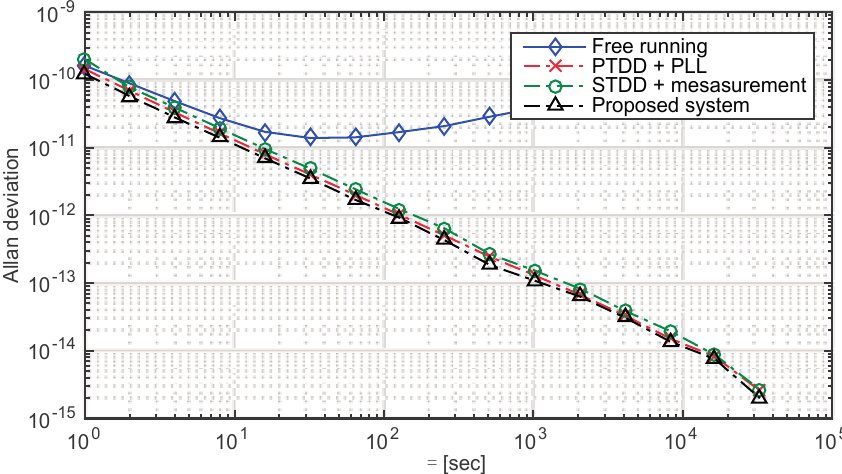
Figure 14. Comparison of the proposed scheme and two existed schemes. The Allan deviations of a free run slave clock and related controlled clock are presented. Data from the 1st h to the 24th hour are truncated to evaluate the synchronization performance. The standard deviations of the free run clock and the stable loops are 1.2 microsecond, 0.15 nanosecond, 0.18 nanosecond and 0.12 nanosecond,